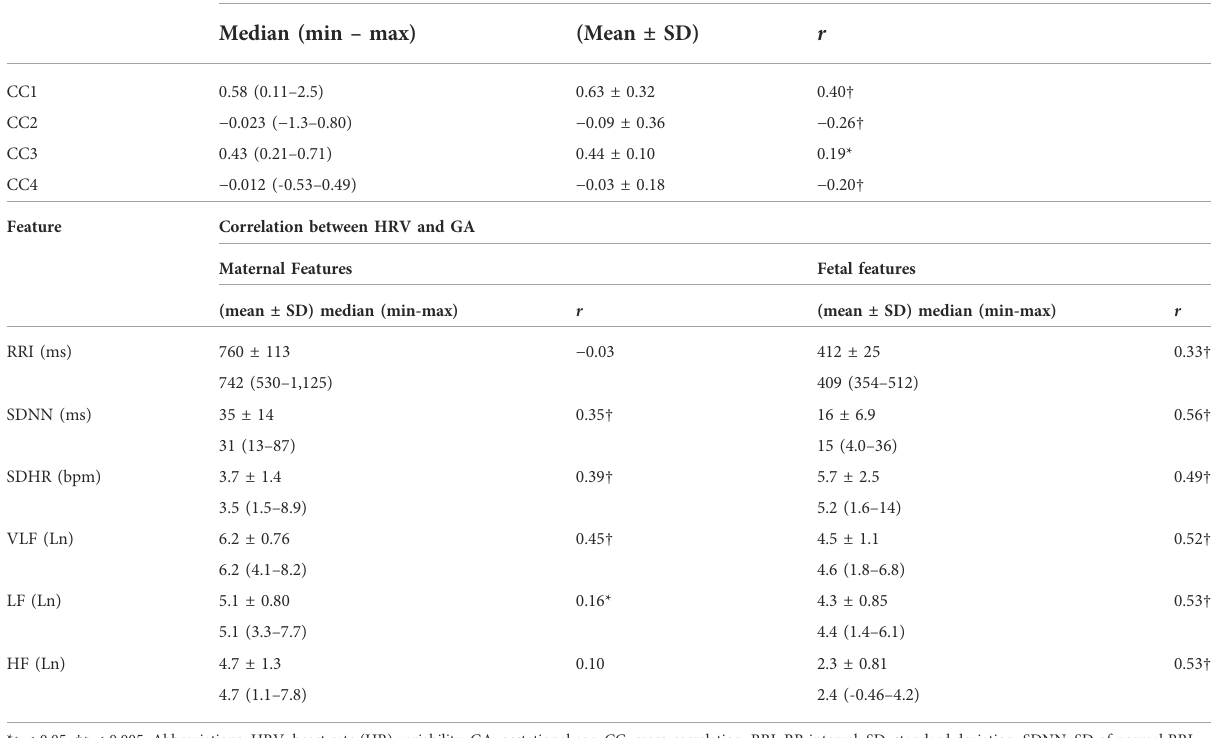
TABLE 1 Summary of maternal and fetal HRV, CC coef fi cients and their correlations with GA, n = 172.